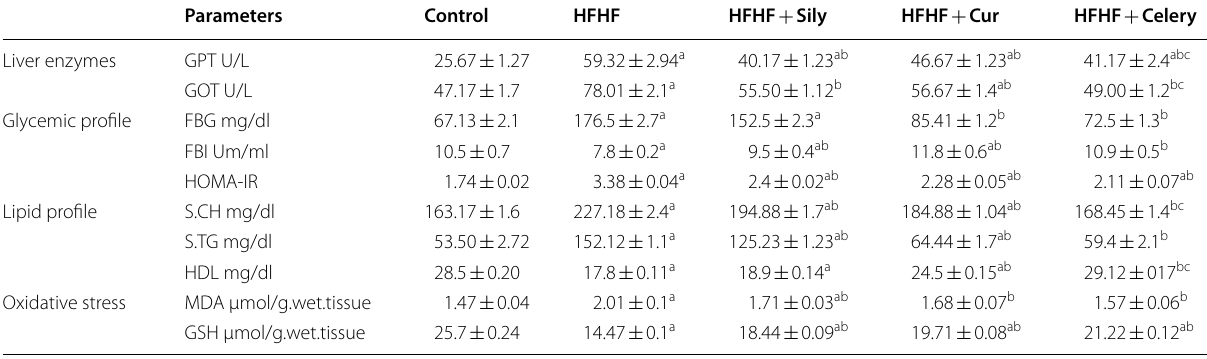
Data represented by mean ɑ p significant difference from control at P <